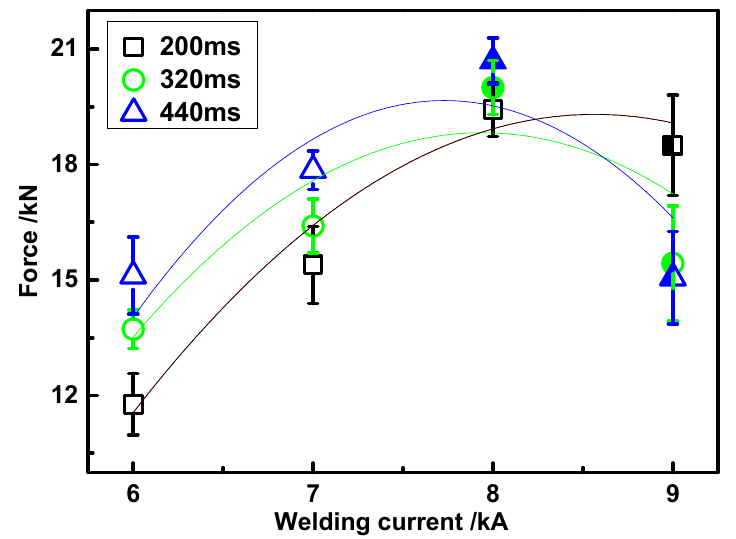
Figure 2. TSS and failure modes of resistance spot welded 1.2 mm thick MS1400 steel.